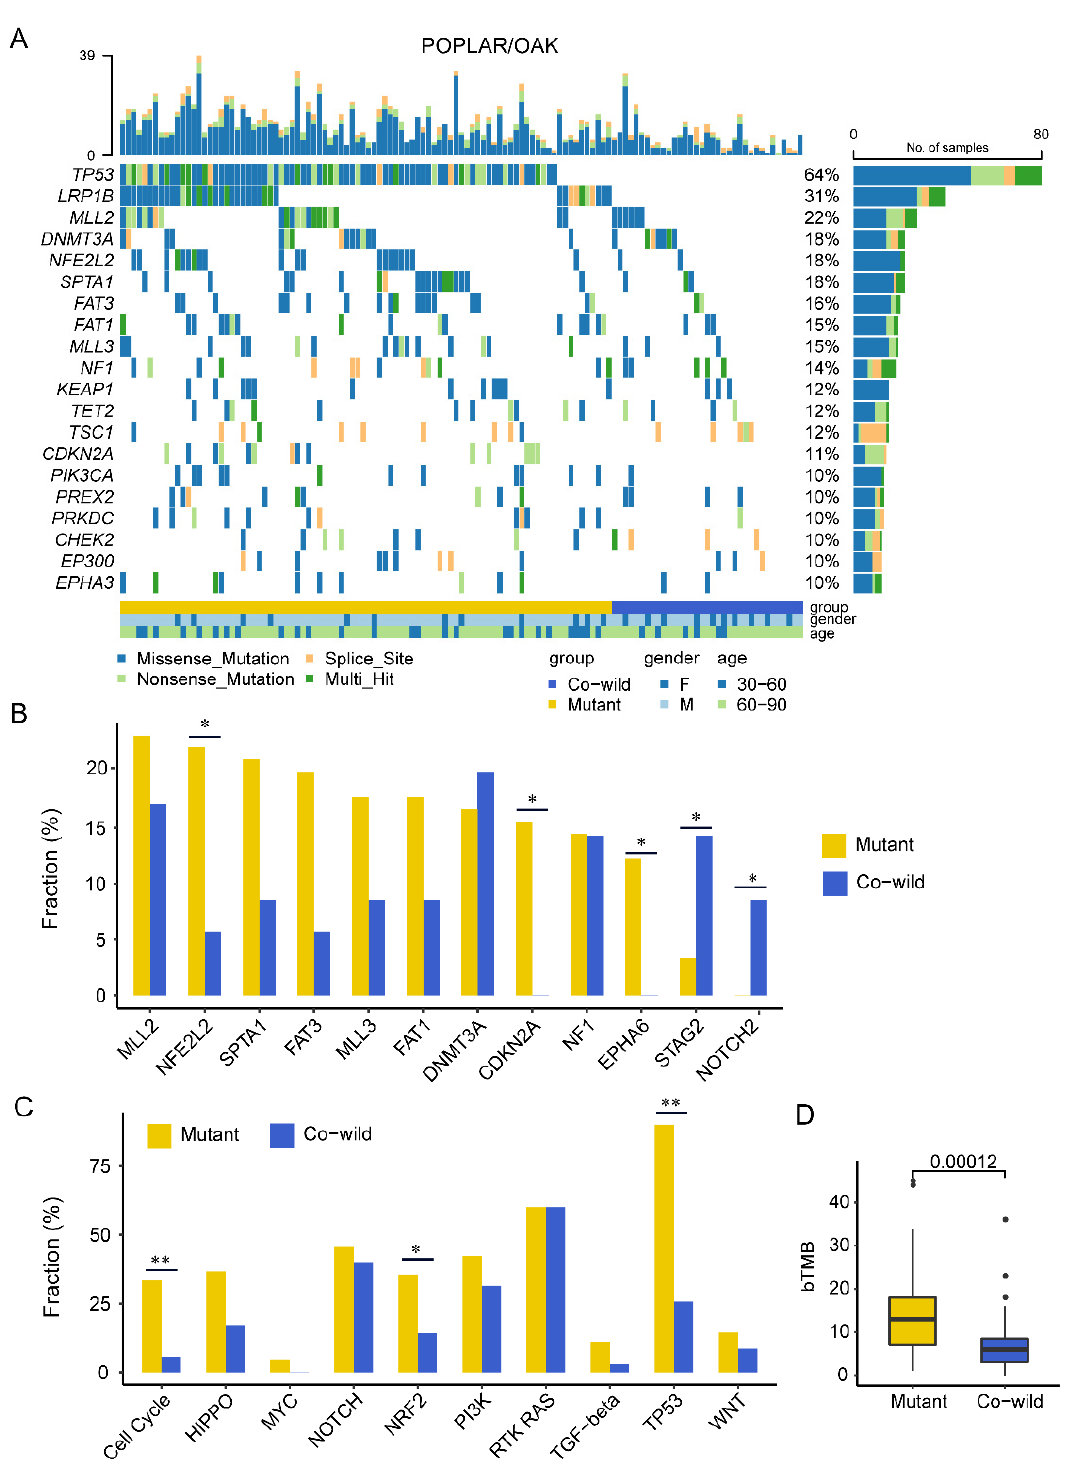
Figure 3. Mutational characteristics of TP53 / LRP1B mutant and co-wild LUSC in POPLAR/OAK cohort. ( A ) The mutational landscapes of TP53/LRP1B mutant and co-wild LUSC. ( B ) Comparison of high-frequency and differential genes in two types. ( C ) Comparison of ten oncogenic signaling pathways between TP53/LRP1B mutant and co-wild LUSC. ( D ) The bTMB of TP53/LRP1B mutant and co-wild LUSC. * p < 0.05, and ** p < 0.01.